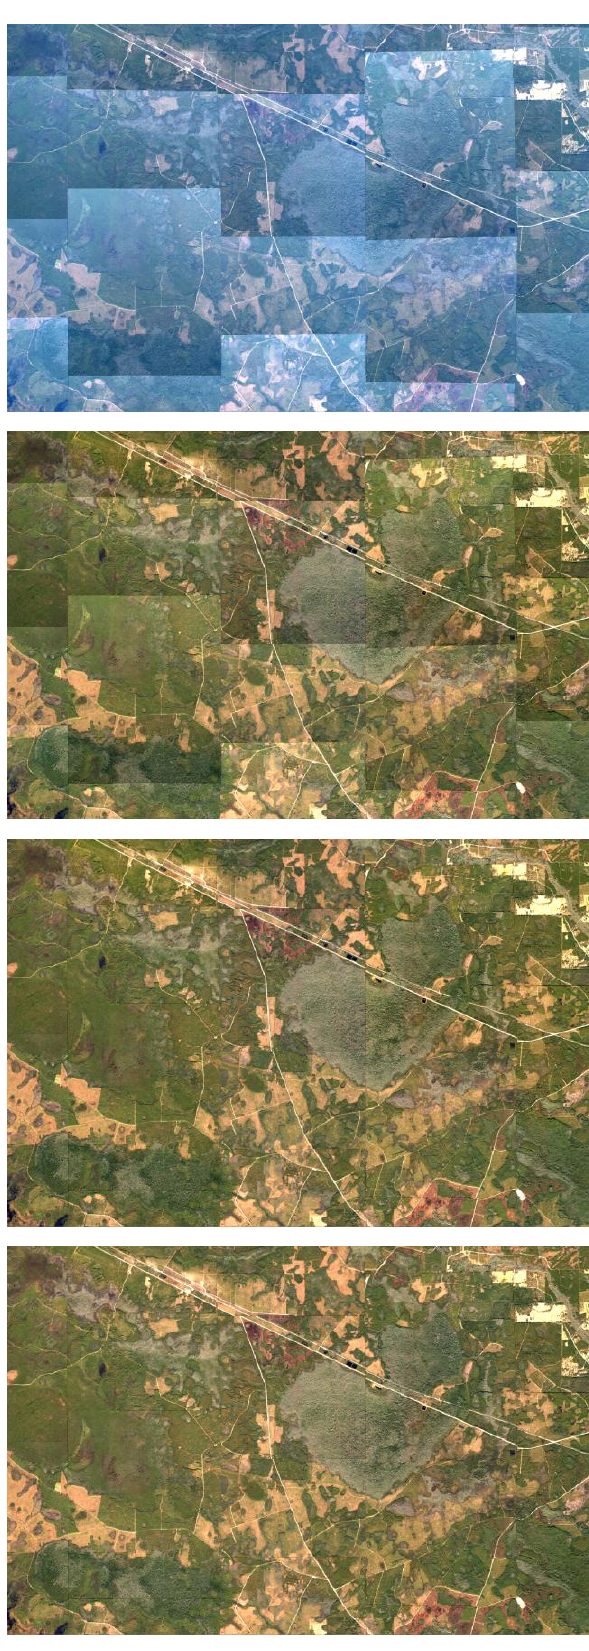
Figure 4. DMC radiometry correction chain for a sub-section of Baker County. From top to bottom: imagery after subsequent sensor calibration, dark pixel subtraction, gradient correction, and final radiometric normalization.